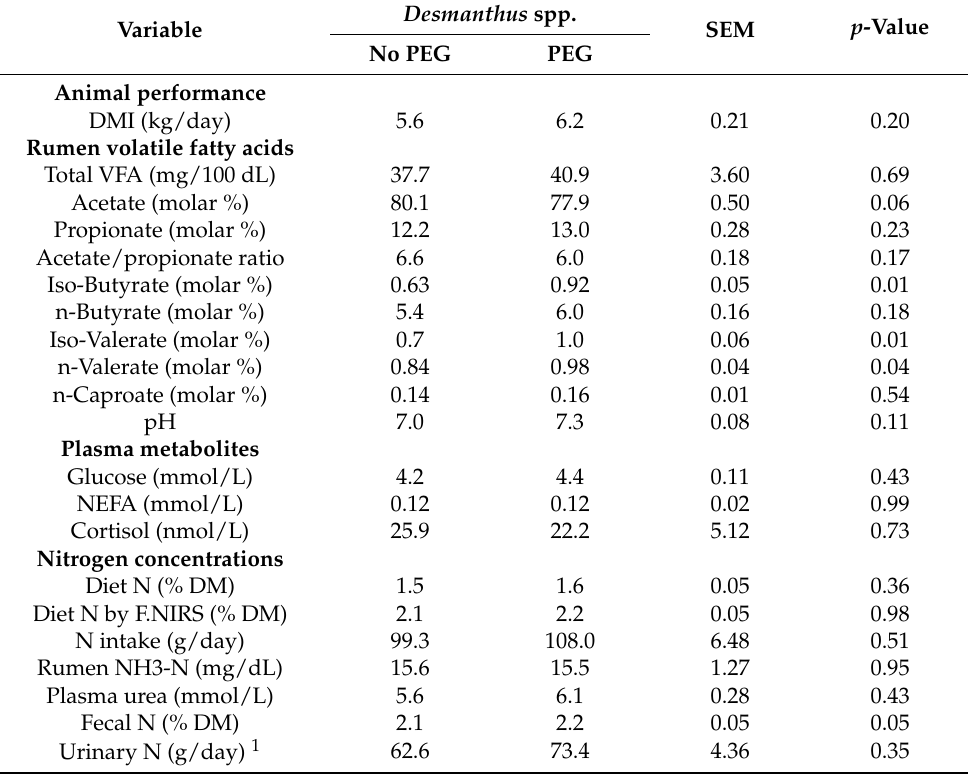
Table 7. Effect of polyethylene glycol on animal performance, rumen VFA, plasma metabolites, and nitrogen